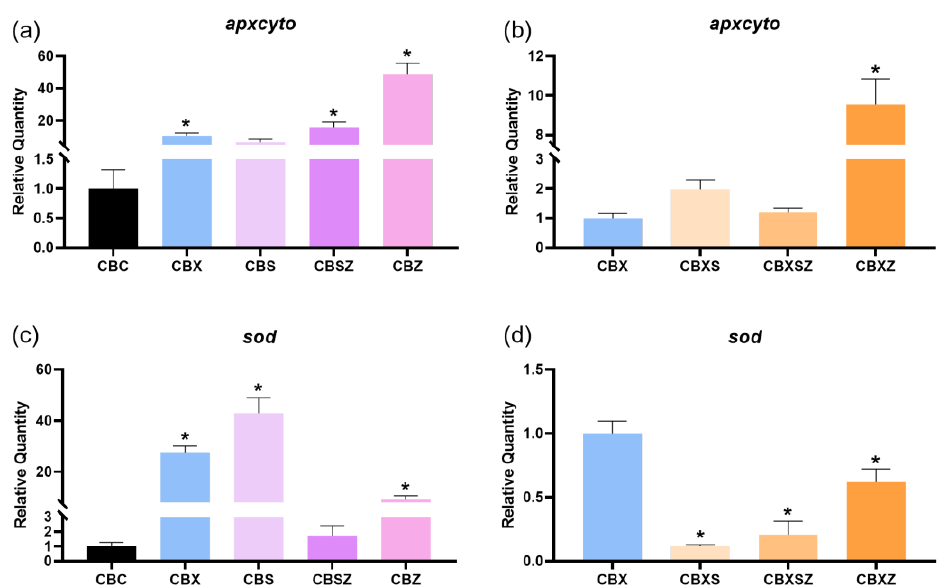
Figure 8. Relative expression levels of genes related to the antioxidant/enzymatic pathway, apxcyto ( a , b ) and sod ( c , d ) 10 days after treatments. Expression levels were determined by quantitative PCR. a and c stand for the uninfected/treated groups (CBS; CBSZ; CBZ) and the infected/untreated group (CBX) compared to the negative control (CBC). ( b , d ) represent the infected/treated groups (CBXS; CBXSZ; CBXZ) compared to the positive control (CBX). The values are presented as mean ± standard deviation, and all values marked with an asterisk are statistically different by the Dunnett comparison test ( p < 0.05).